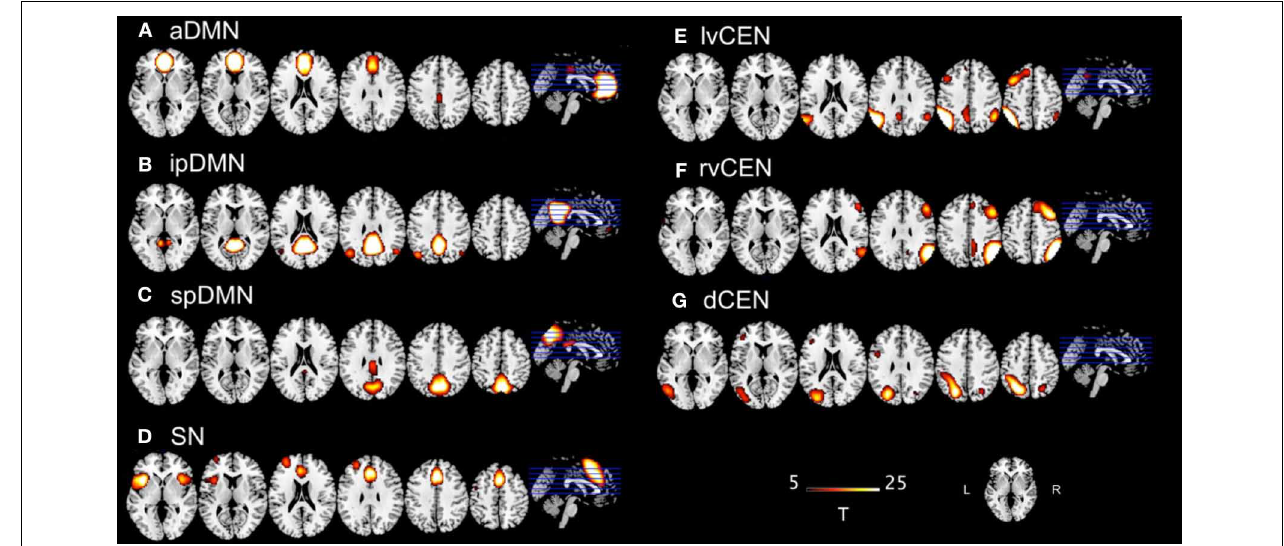
FIGURE 1 | T-maps of intrinsic connectivity networks of interest as described and provided online by Allen et al. (2011). Allen and colleagues used an ICA model-order of 75 to decompose rs-fMRI data of 603 subjects, obtaining 28 components. T-maps of components were provided online (http://mialab.mrn.org/data/hcp/RSN_HC_unthresholded_ tmaps.nii). As previously reported (Manoliu et al., 2013b), we chose the T-maps of ICs representing the default mode network, salience network and central executive network, and performed multiple spatial regression analyses of our 75 independent components’ spatial maps on these